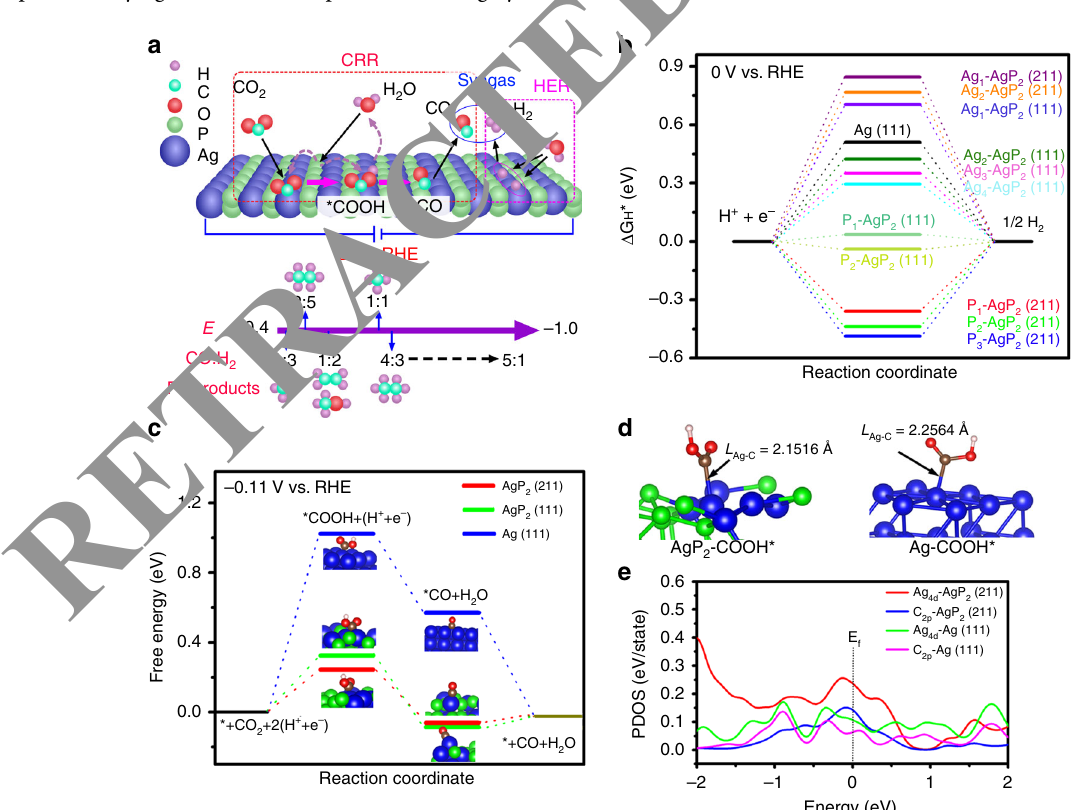
Fig. 3 Density functional theory calculations. a Schematic diagram of selective CO 2 -to-syngas on AgP 2 (211). Free energy change ( Δ G ) calculated for the b HER and c selective CO 2 -to-CO reaction. d Optimized *COOH adsorption con fi guration and e corresponding PDOS on AgP 2 (211) and Ag (111). NATURE COMMUNICATIONS| (2019) 10:5724